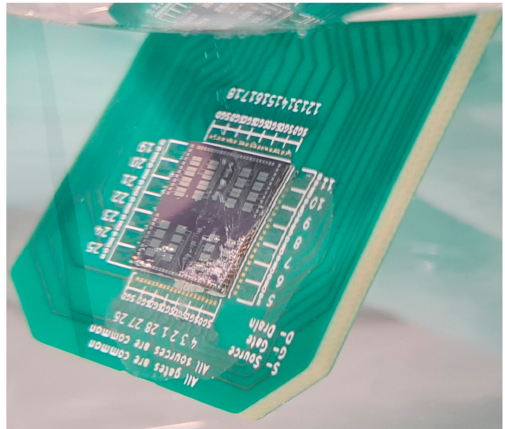
Figure A2. Bubble formation (bo tt om right corner of the chip) in water along the contacts when applying voltage larger than 1 V, due to water electrolysis.